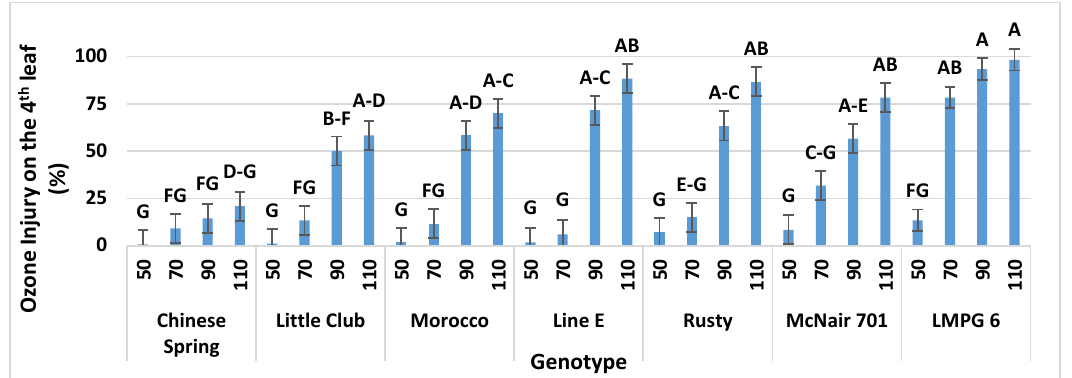
Figure 6. Effect of four different O 3 levels (50, 70, 90, and 110 ppb) on O 3 injury on the fourth leaf of rust near-universal susceptible genotypes, exposed for 5 days (7 h/day), at 25 °C and 60% RH, in CSTRs. Injury were visually estimated, under constant light conditions according to a 0 – 100% scale. Values are means (±SE) statistically separated using Tukey-Kramer adjustment for multiple comparisons. Means marked with the same letter are not significantly different at α = 0 .05.